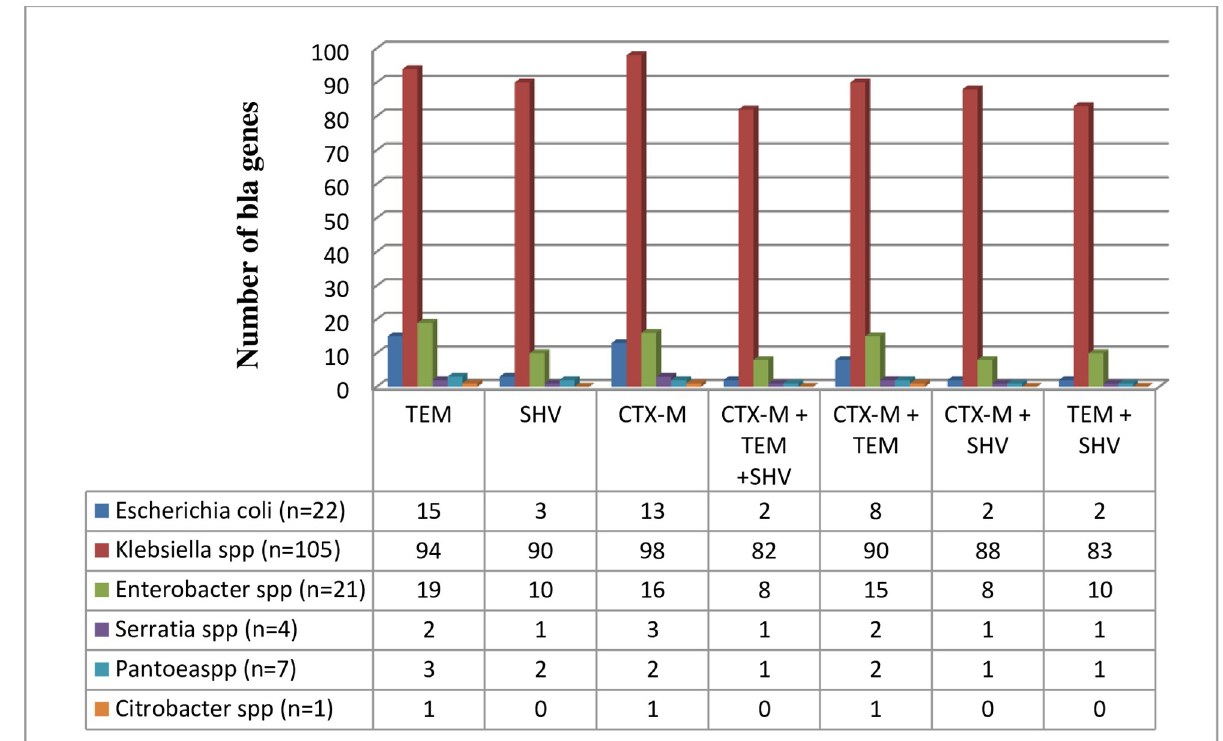
Fig 3. Prevalence of ESBL genes among Enterobacteriaceae isolates.